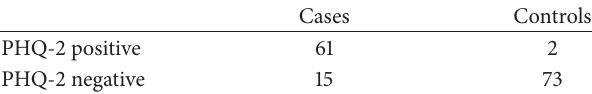
Table 3: Sensitivity and specificity of the PHQ-2 screener. Cases